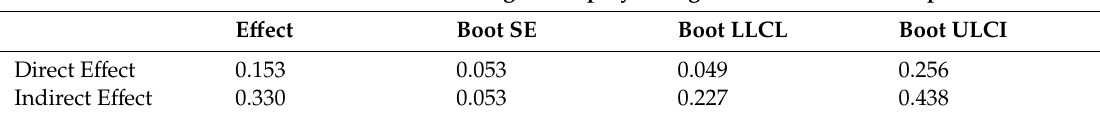
Table 4. Mediation e ff ects of work engagement.